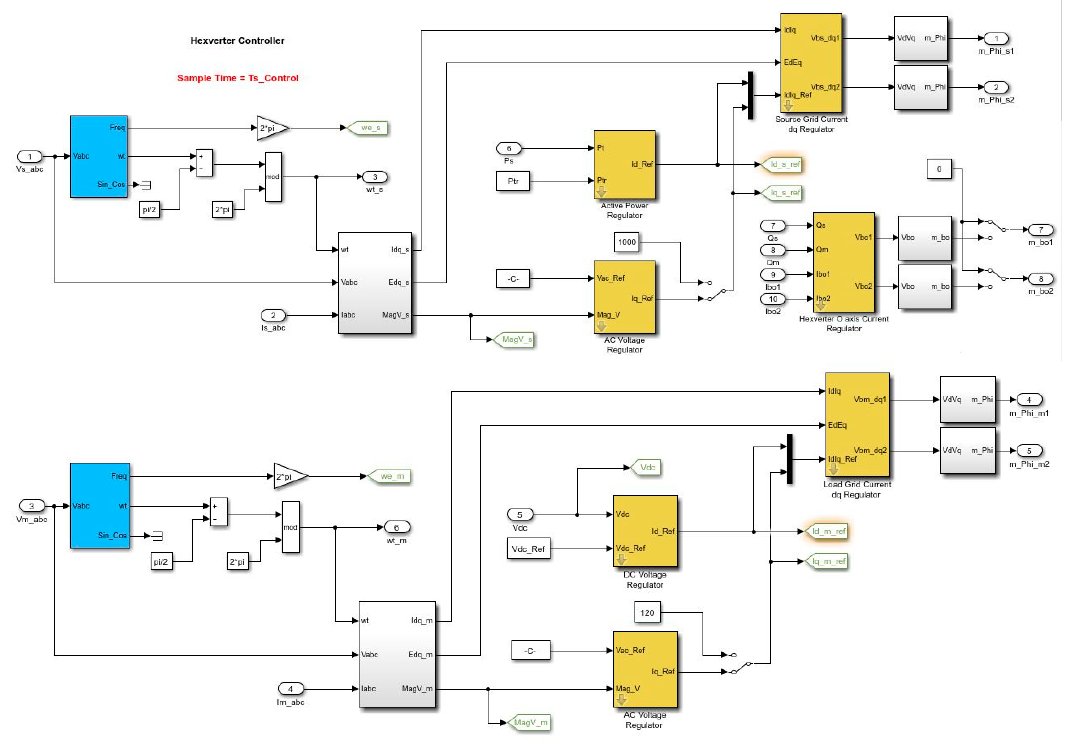
Figure 8. Control system for hexverter.